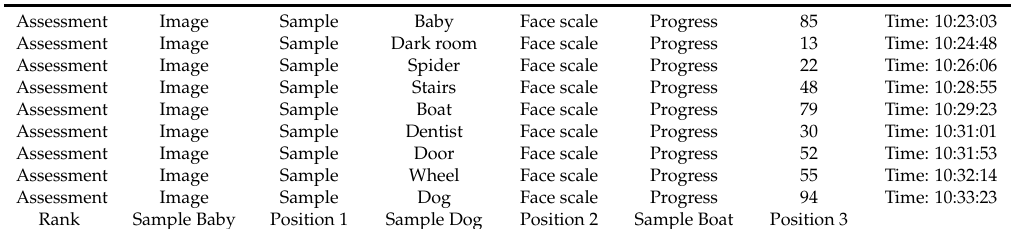
Table 1. Example of the output of data obtained from the biosensory app in text file when opened in